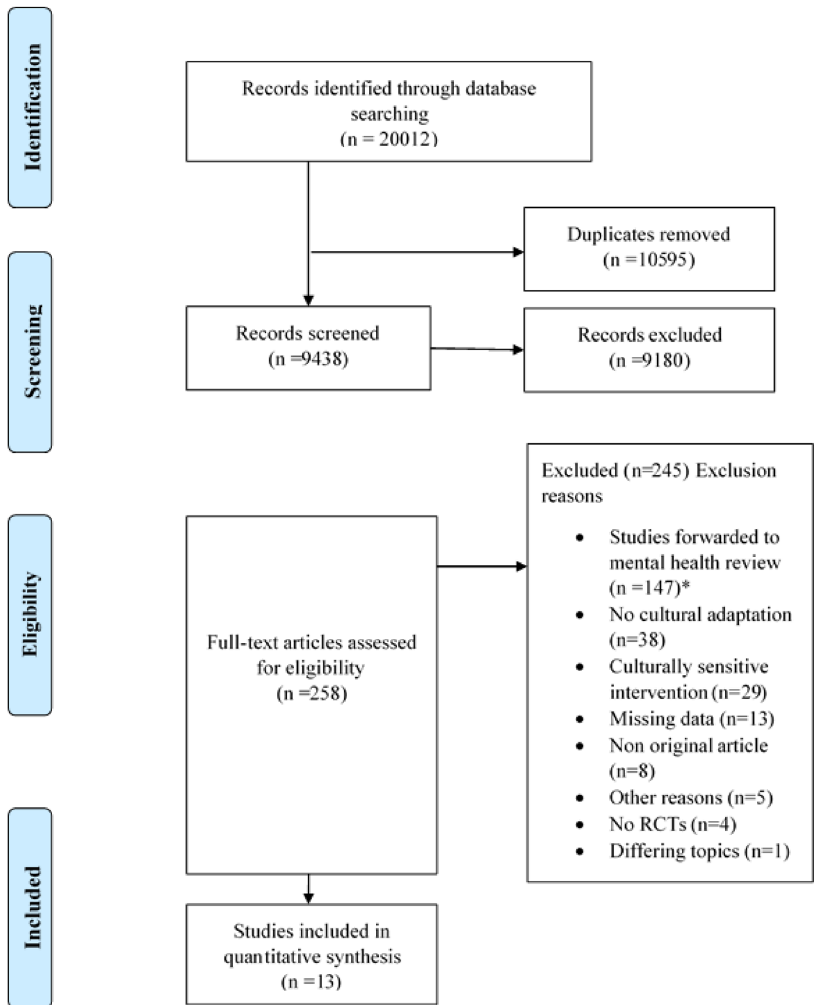
Fig. 8 Prisma Flow chart 92 . Study identi fi cation, selection, and inclusion represented on the diagram. An asterisk symbol represents a parallel review conducted regarding the culturally adapted internet- and mobile-based interventions concerning mental